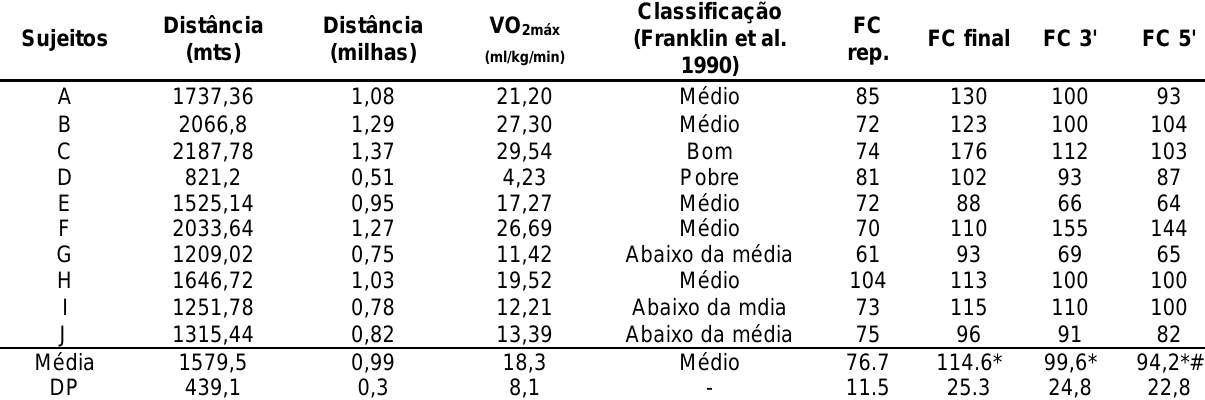
Tabela 3. Resultados e classificação dos sujeitos no teste de estimativa da potência aeróbia. Sujeitos